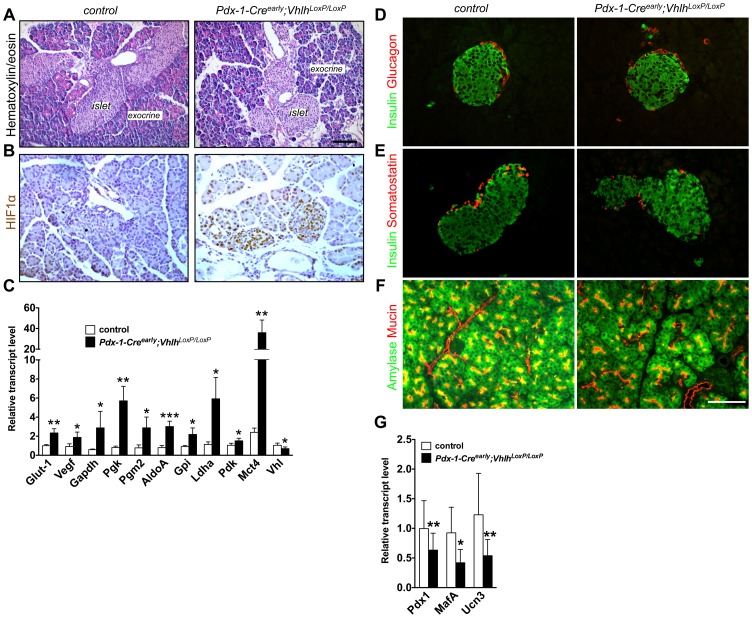

Pdx-1-Creearly;VhlhLoxP/LoxP pancreata have alterations in metabolic and ß-cell genes but no change in morphology.
A. Histological examination of pancreatic tissue from pups (p15) with Hematoxylin/Eosin staining shows the presence of normal exocrine and endocrine compartments in control and mutant mice. Size bar, 100 µm. B. Robust HIF1α accumulation is evident in pancreatic tissue (including endocrine, acinar and ductal cells) from Pdx-1-Creearly;VhlhLoxP/LoxP mice (p15). C. Quantitative PCR was used to evaluate gene expression within the postnatal pancreas (p13-p18). HIF target genes including Glut-1, Vegf, glycolytic enzymes (Gapdh, Pgk, Pgm2, AldoA, and Gpi), and lactate biosynthetic genes (Ldh, Pdk, Mct4) were significantly upregulated, while Vhlh expression was reduced. Normalization of gene expression was to the housekeeping gene cyclophilin A. Five control and six mutant samples were analyzed. *p<0.05, **p<0.005, ***p<0.0005. Error bars represent standard deviation. Immunofluorescence confirms the expression of endocrine hormones insulin (D,
E, green), glucagon (D, red), and somatostatin (E, red), and exocrine markers amylase (F, green) and mucin (F, red) in control and mutant tissues. Size bar, 50 µm. G. Gene expression of canonical ß-cell genes was evaluated using quantitative PCR in islets isolated from the postnatal pancreas (p13-p18). Markers of ß-cell maturity including Pdx-1, MafA and Urocortin3 were reduced in their expression levels. Normalization of gene expression was to the housekeeping gene cyclophilin A. Six control and six mutant samples were analyzed. *p<0.05, **p<0.005, ***p<0.0005. Error bars represent standard deviation.